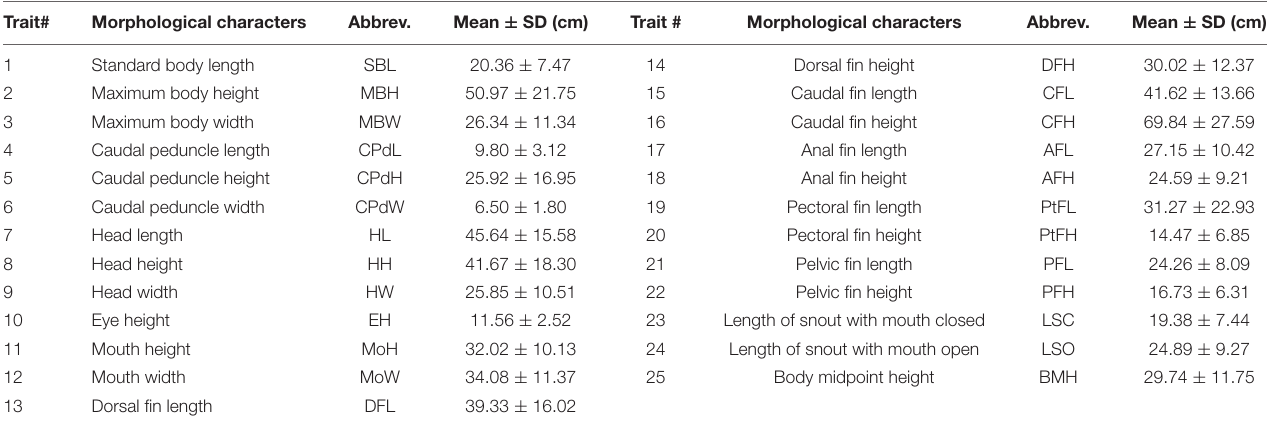
TABLE 1 | Mean and standard deviation for each of the linear morphometric